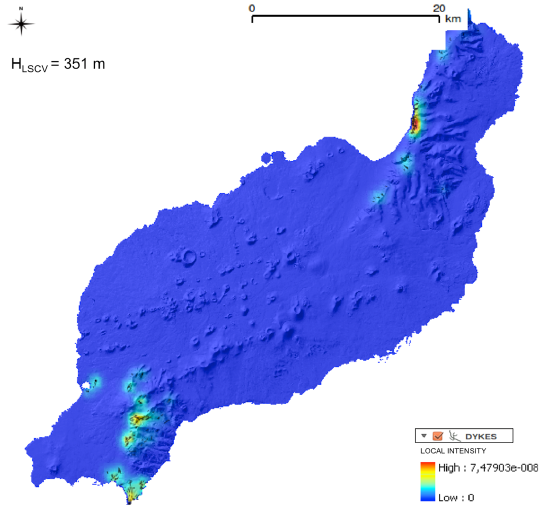
Fig. 7. PDF of Lanzarote dykes calculated with the Gaussian kernel using a bandwidth of